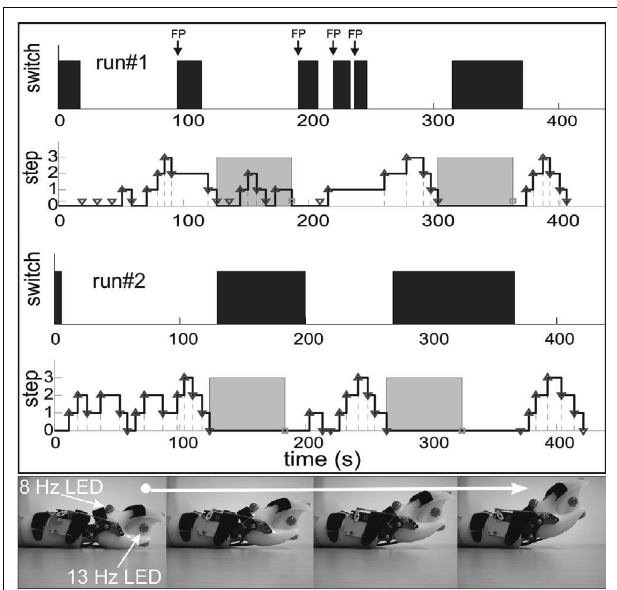
FIGURE 3 | Examples of two runs (runs #1 and #2) in one able-bodied subject (s3) over several minutes each. The lower traces of runs #1 and #2 display the four-step sequence of opening/closing the SSVEP-based orthosis with two 60-s breaks (grey shaded). The upper traces of runs #1 and #2 show the ERS-based switch operation (black bars indicate switch opened). The four-steps of orthosis opening (from left to right) are displayed in the bottom panel.